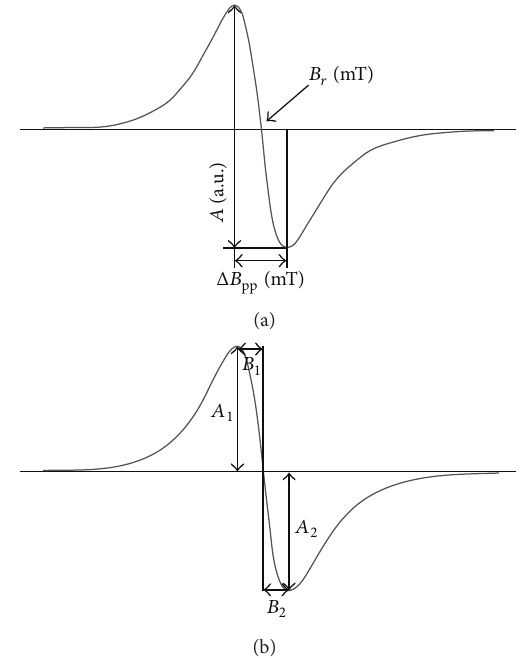
Figure 2: The analysed parameters of the first-derivative EPR —line width, and 𝐵 𝑟 —resonance spectra (a): 𝐴 —amplitude, Δ𝐵 pp magneticinductionandthetestedspectralshapeparameters(b): 𝐴 1 , 𝐵 𝐵 𝐴 2 , 1 , and 2 ,